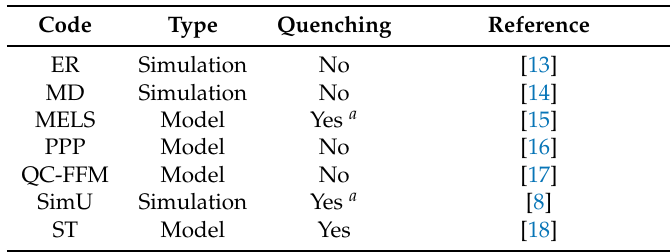
Table 3. Summary of the participating codes.